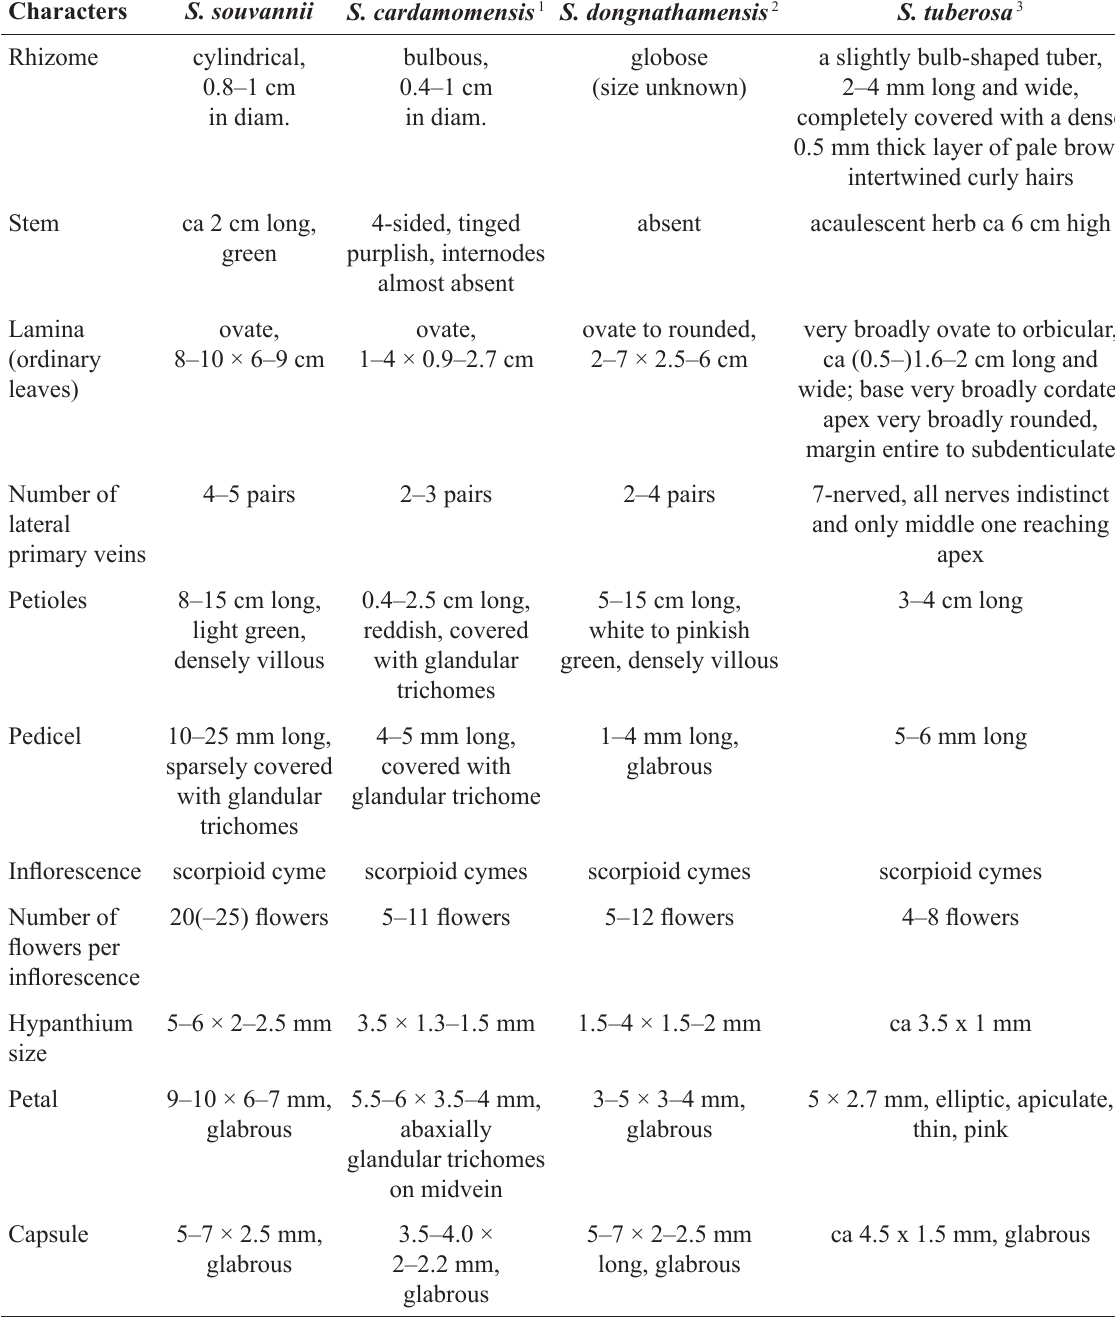
Table 2. Comparison of Sonerila souvannii Phonep. & Soulad. sp. nov., S. cardamomensis S.H.Cho, S. dongnathamensis Suddee, Phutthai & Rueangr., and S. tuberosa C.Hansen. 1 = from Sinh et al.